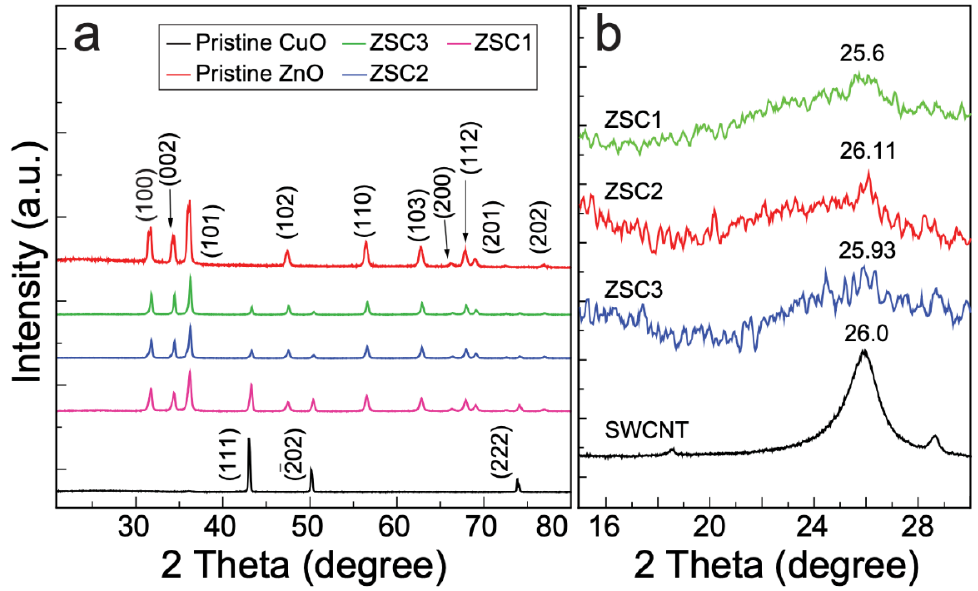
Figure 1. ( a ) XRD plots of the pristine oxides and heteronanocomposites. ( b ) The magnified XRD patterns showing a peak of crystalline carbon, confirming the presence of SWCNTs in the heterojunction nanocomposites.